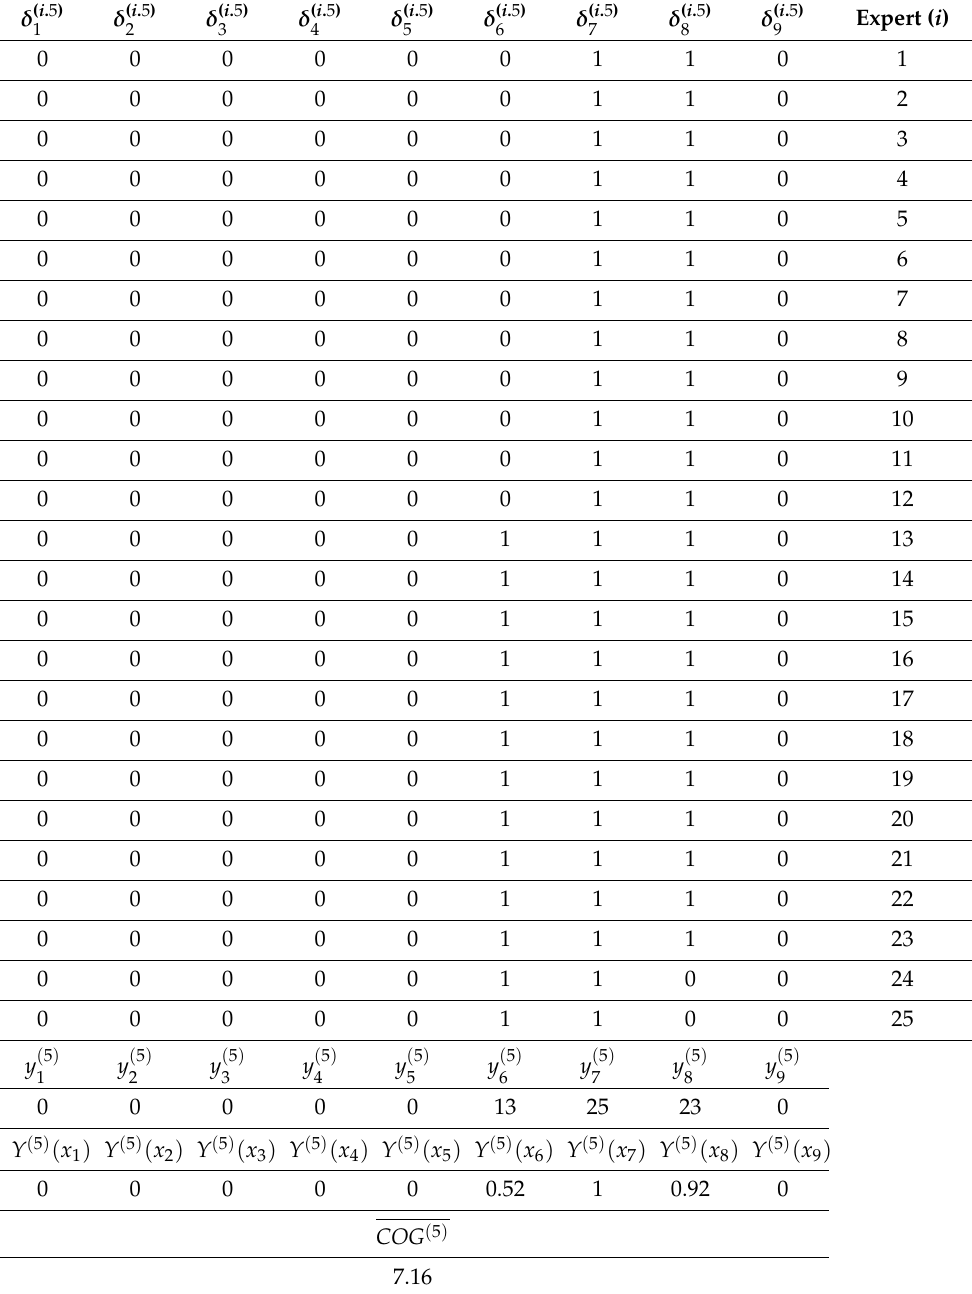
Table 4. Fuzzification and defuzzification of the experts’ opinions. COG: Center of